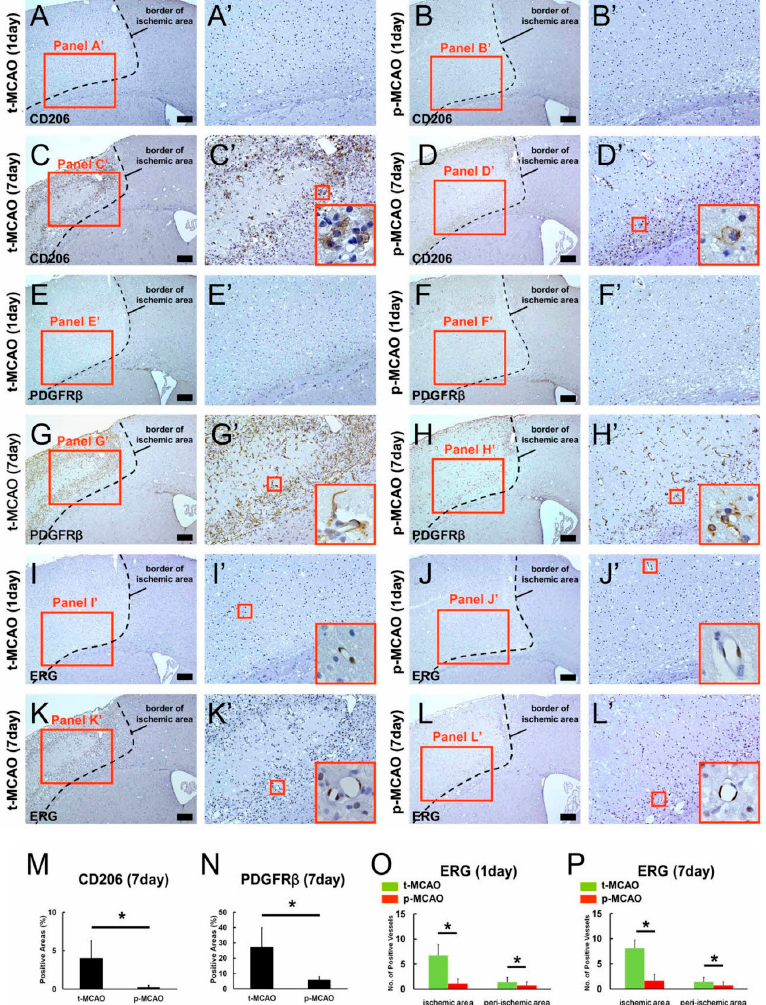
Figure 3. Immunohistochemistry for CD206, PDGFR β , and ERG at 1 d and 7 d after 90-min t-MCAO or p-MCAO. CD206 ( A , A’ , B , B’ ) and PDGFR β ( E , E’ , F , F’ ) were minimally expressed 1 d after 90-min t-MCAO ( A,A’,E,E’ ) and p-MCAO ( B , B’ , F , F’ ). However, at 7 d post stroke, many CD206 + ( C , C’ , D , D’ ) and PDGFR β + cells ( G , G’ , H , H’ ) were observed within the ischemic areas after 90-min t-MCAO ( C , C’ , G , G’ ) and p-MCAO ( D , D’ , H , H’ ). Quantitative analysis at 7 d post stroke showed that CD206 + ( M ) and PDGFR β + areas ( N ) were significantly larger in mice after 90-min t-MCAO compared to p-MCAO. ERG + endothelial cells were observed within the ischemic areas 1 d ( I , I’ , J , J’ ) and 7 d ( K , K’ , L , L’ ) after 90-min t-MCAO ( I , I’ , K , K’ ) and p-MCAO ( J , J’ , L , L’ ). However, quantitative analysis at 1 d ( O ) and 7 d ( P ) post stroke showed that the number of ERG + vessels was significantly higher within the ischemic and peri-ischemic areas after 90-min t-MCAO compared to p-MCAO. Results are representative of three replicates. Scale bars = 200 μ m ( A – L ). * p < 0.05 between stroke models (90-min t-MCAO vs. p-MCAO) ( M – P ) ( n = 3, for each model). Abbreviations: CD206, cluster of